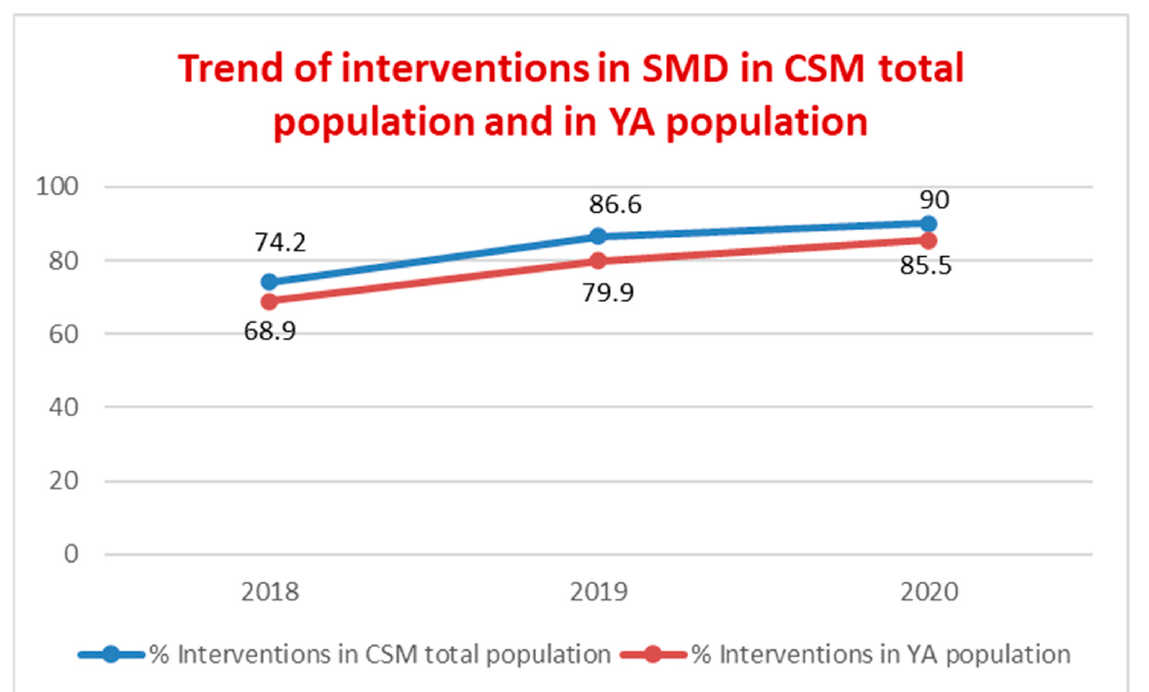
Figure 1. Prevalent YA patients and incident YA patients—Integrated projects and integrated treat- ment profiles.